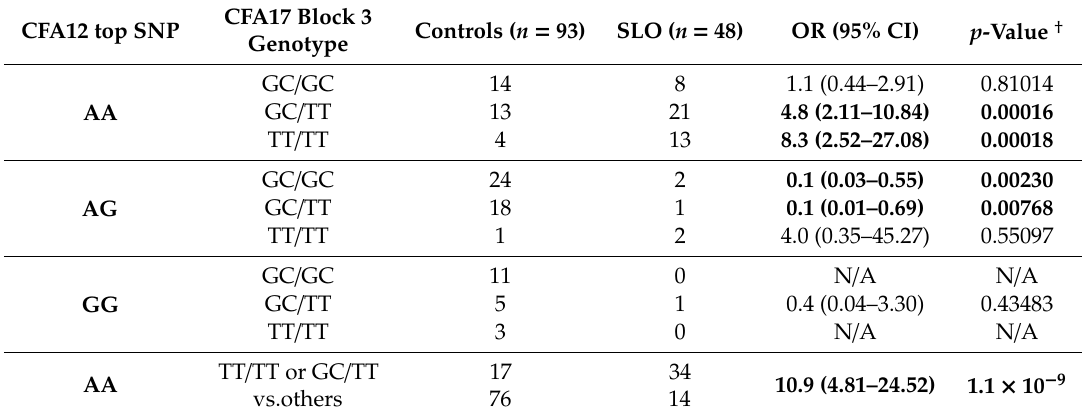
Table 3. CFA12 top SNP and CFA17 block 3 genotypes (17:45,646,810–45,660,242) in 141 Bearded Collies (48 SLO, 93 controls) with known genotypes. The bolded values were statistically significant at p <